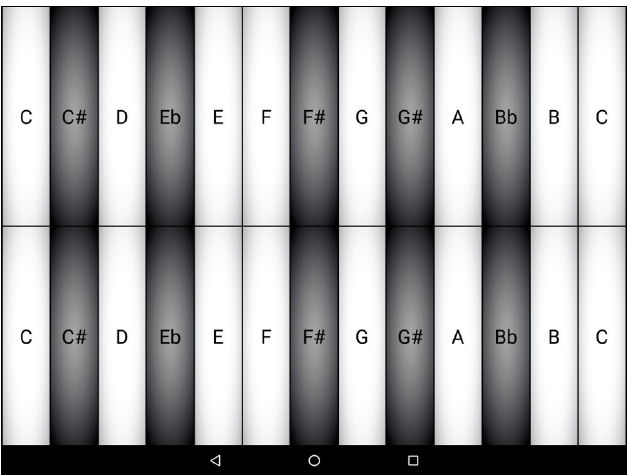
Figure 2. Simple S MART K EYBOARD